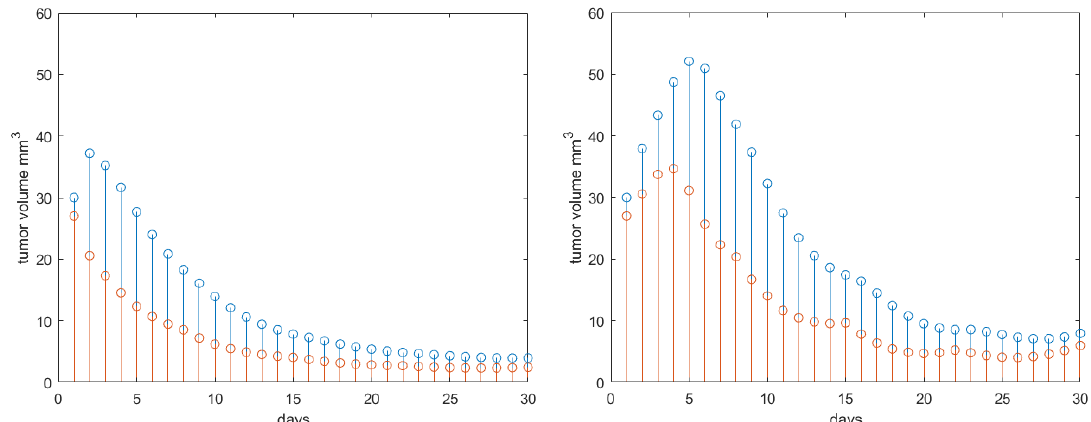
Figure 8. Results obtained for Protocol 3 in tumor growth volume with patient response degree varying from 1 (drug sensitive) to 8 (drug resistant). Red stems denote the active tumor volume and blue stems the total tumor